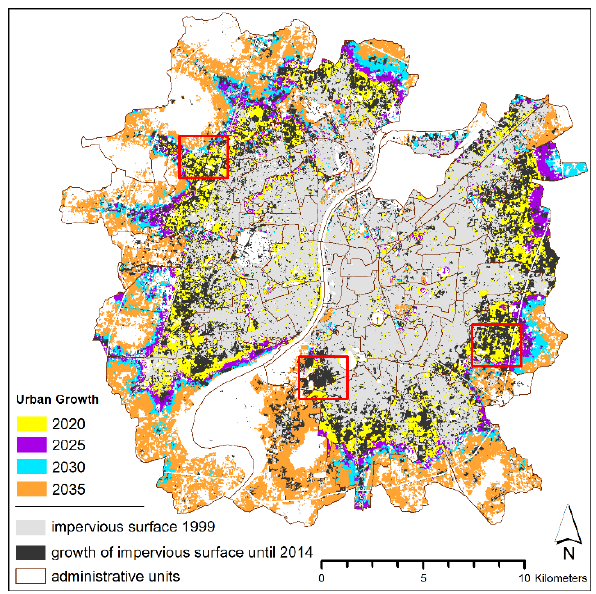
Figure 9: Urban Growth Scenario